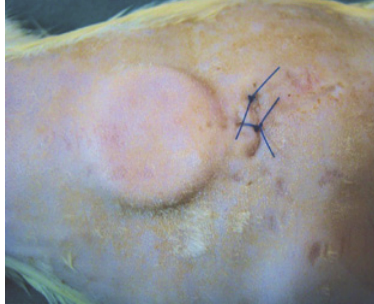
FIGURE 3 - Implant in surgical position.